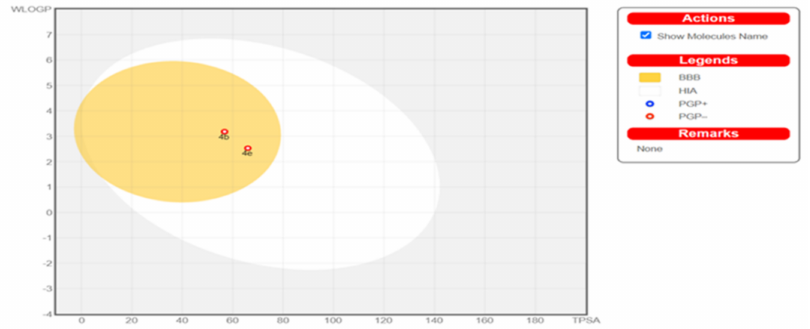
Figure 12. Predicted Boiled-Egg plot from SwissADME online web tool for compounds ( 4b and 4e ).